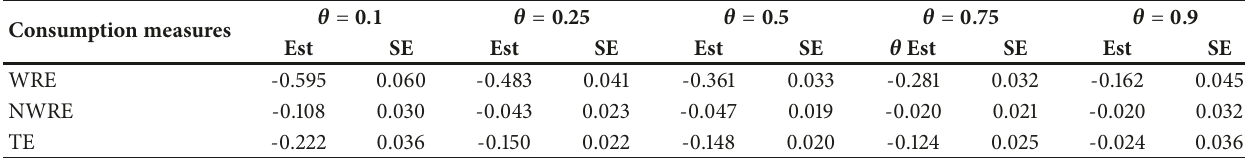
Table 4: Regression estimate for frequentist quantile regression